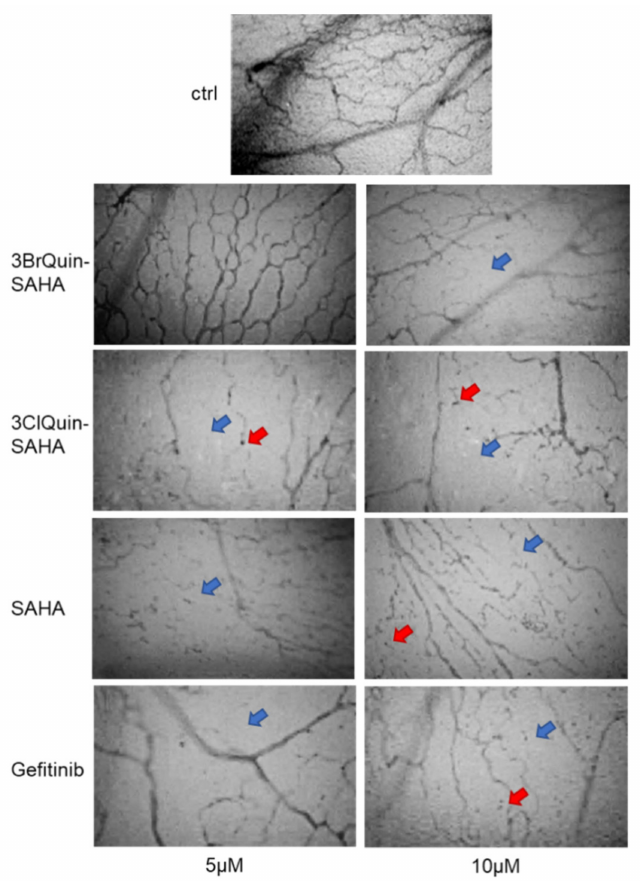
Figure 7. Antiangiogenic effects of 3BrQuin-SAHA and 3ClQuin-SAHA. Representative images from n = 3 preparations per condition of treatment-induced changes in the development and morphology of the vasculature of the chorioallantoic membrane (CAM) of fertilized chicken eggs after 72 h of topical treatment with 3BrQuin-SAHA, 3ClQuin-SAHA, SAHA, and gefitinib. Compared to untreated control CAMs, a dose-dependent reduction in the number (blue arrow) and altered morphology (red arrow) of CAM micro-vessels was observed. Most pronounced effects were seen in 3ClQuin-SAHA- treated